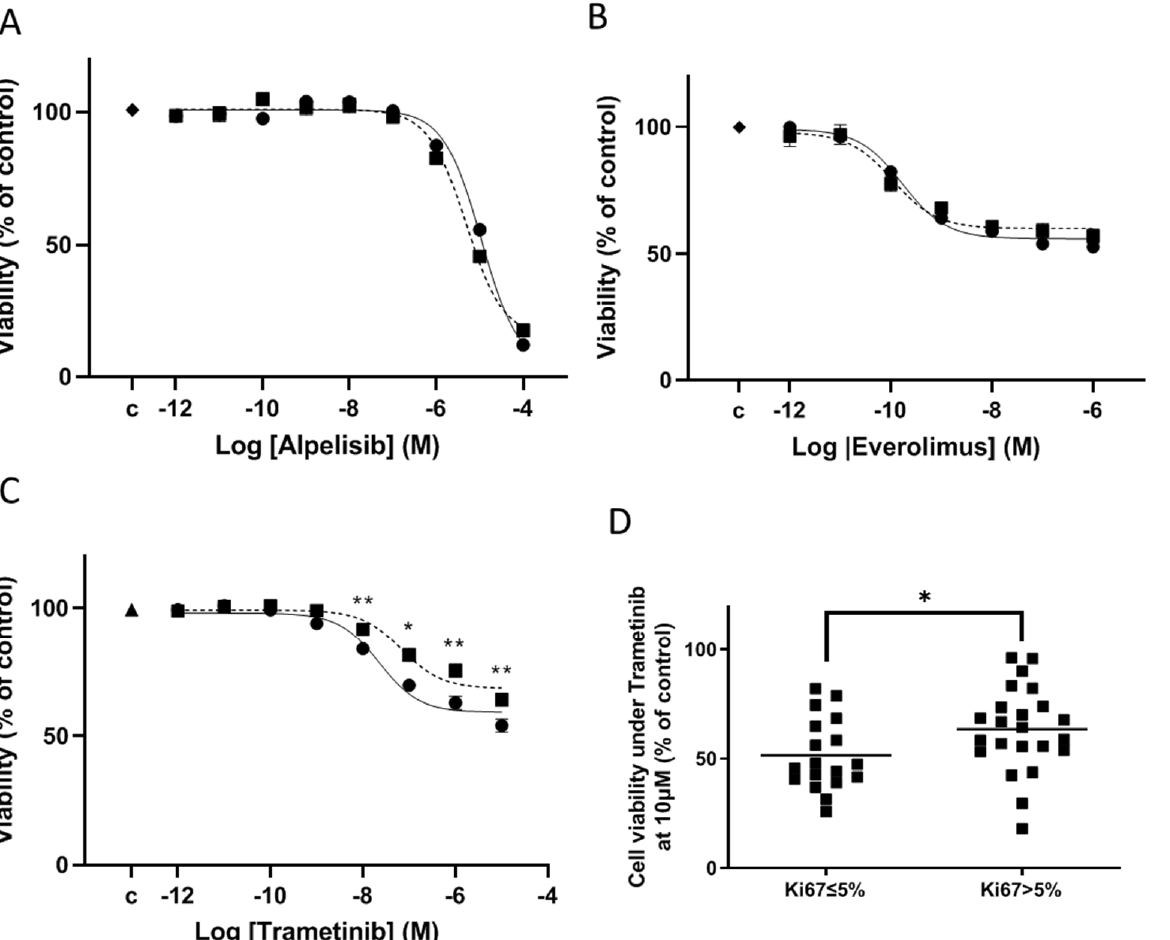
Figure 5. Dose-effect curve on cell viability under treatment with alpelisib ( A ), everolimus ( B ) or trametinib ( C , D ) for 3 days, quantified using a cell viability assay. Results are expressed as mean ± SEM percentage of cell viability in comparison to DMSO (dimethylsulfoxide)-treated control cells (“c”). Overall, 32 tumors, randomly selected were tested after administration of alpelisib and everolimus (mean inhibitory effect on 20 grade 1 tumors [continuous line] vs. mean inhibitory effect on 12 grade 2 or 3 tumors [dotted line]), and in ( C ) 42 after trametinib (mean inhibitory effect on 25 grade 1 [continuous line] vs. mean inhibitory effect on 17 grade 2 or 3 [dotted line], ** p < 0.01: comparison of trametinib inhibitory effect in the 25 grade 1 tumors vs. in the 17 grade 2 and 3 tumors at each concentration). In ( D ), the effect on cell viability of 10 − 6 M trametinib in the 42 tumors classified according to their Ki67 index (less than or equal to 5% and greater than 5%). Black line: mean Ki67 index. * p < 0.05.